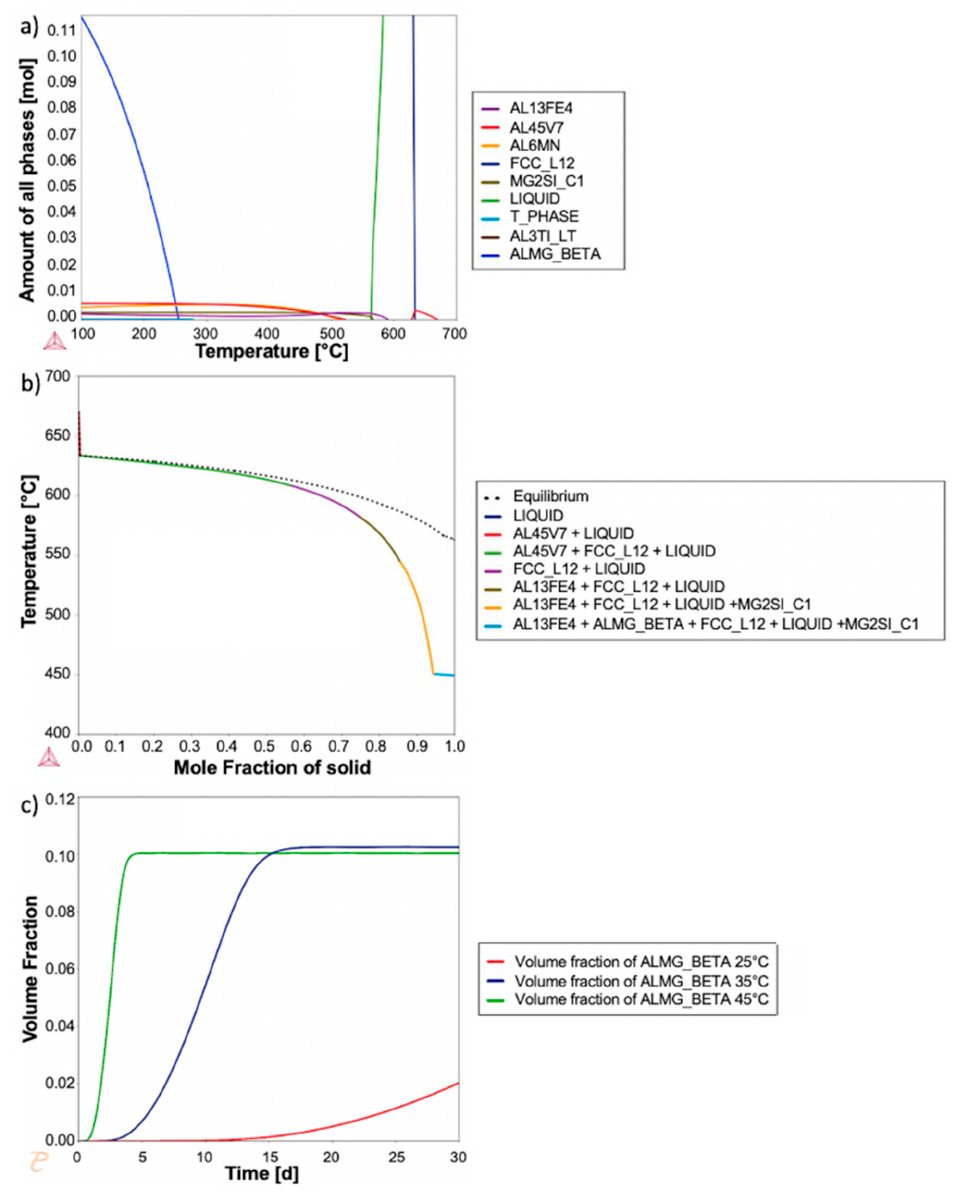
Figure 1. Thermodynamic models produced using Thermo-Calc. ( a ) Equilibrium diagram and ( b ) Scheil (non-equilibrium) solidification diagram. ( c ) Volume fraction as a function of time for β -Al 3 Mg 2 precipitate.